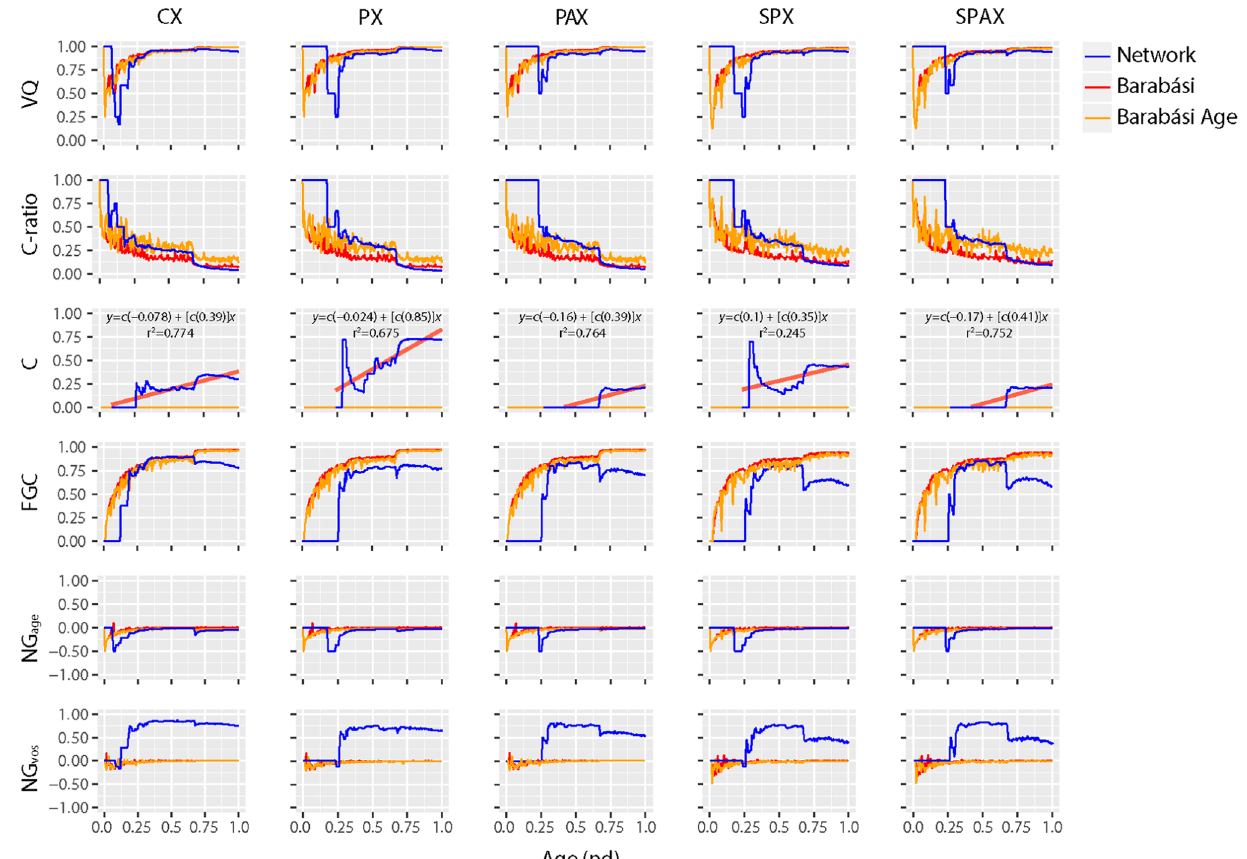
Figure 5. Network modularity. Six indicators of modularity were studied along the evolutionary timeline to explore the evolution of network structure, with network age ( nd ) indicated on a relative 0-to-1 scale. Modularity indices include the VOS Quality (VQ) index, the Clustering ratio (C-ratio), the average Clustering Coefficient (C), the Fast-Greedy Community (FGC) index, and the Newman-Girvan index defined by age (NG age ) or VOS clustering (NG VOS ). Modularity calculations required cumulative, undirected, and weighted connectivity input. The Barabási (red) and Barabási-Age (orange) models (see caption of Fig. 4) were included as control sets. The regressions of C with age (nd) are shown as linear models (red lines) for each network together with supporting determination coefficients (R 2